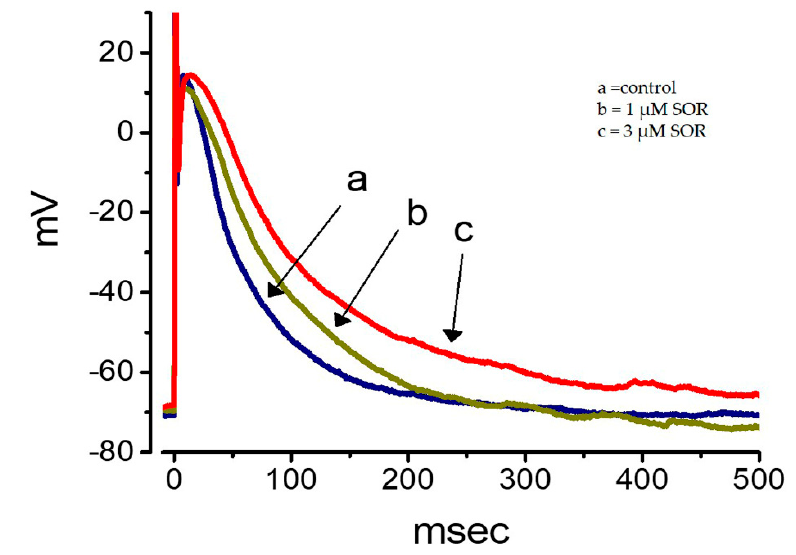
Figure 6. Effect of SOR on the membrane potential in cultured NRVMs. Current-clamp potential recordings were made and cells were bathed in normal Tyrode’s solution containing 1.8 mM CaCl 2 . Potential trace labeled ‘a’ is the control, and those labeled ‘b’ and ‘c’ were obtained during the exposure to 1 and 3 M SOR, respectively.